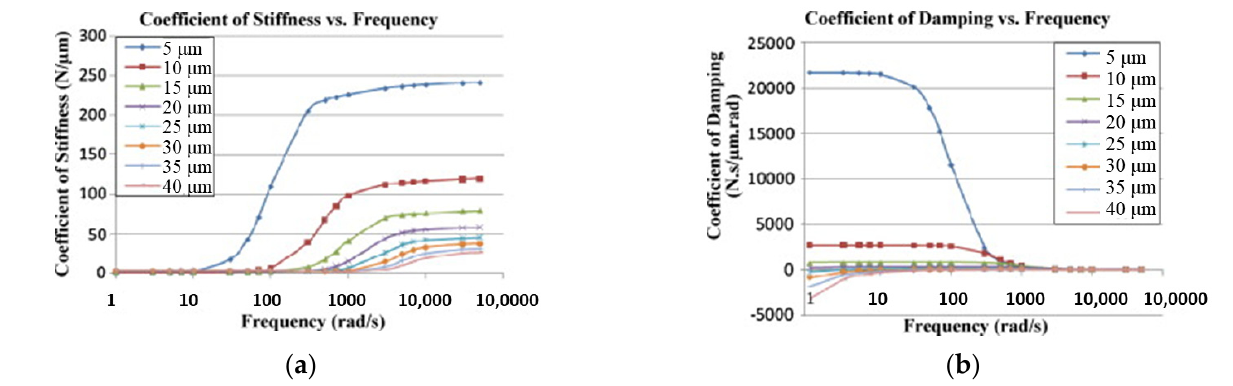
Figure 11. The effects of gap height and perturbation frequency on the dynamic performance of the